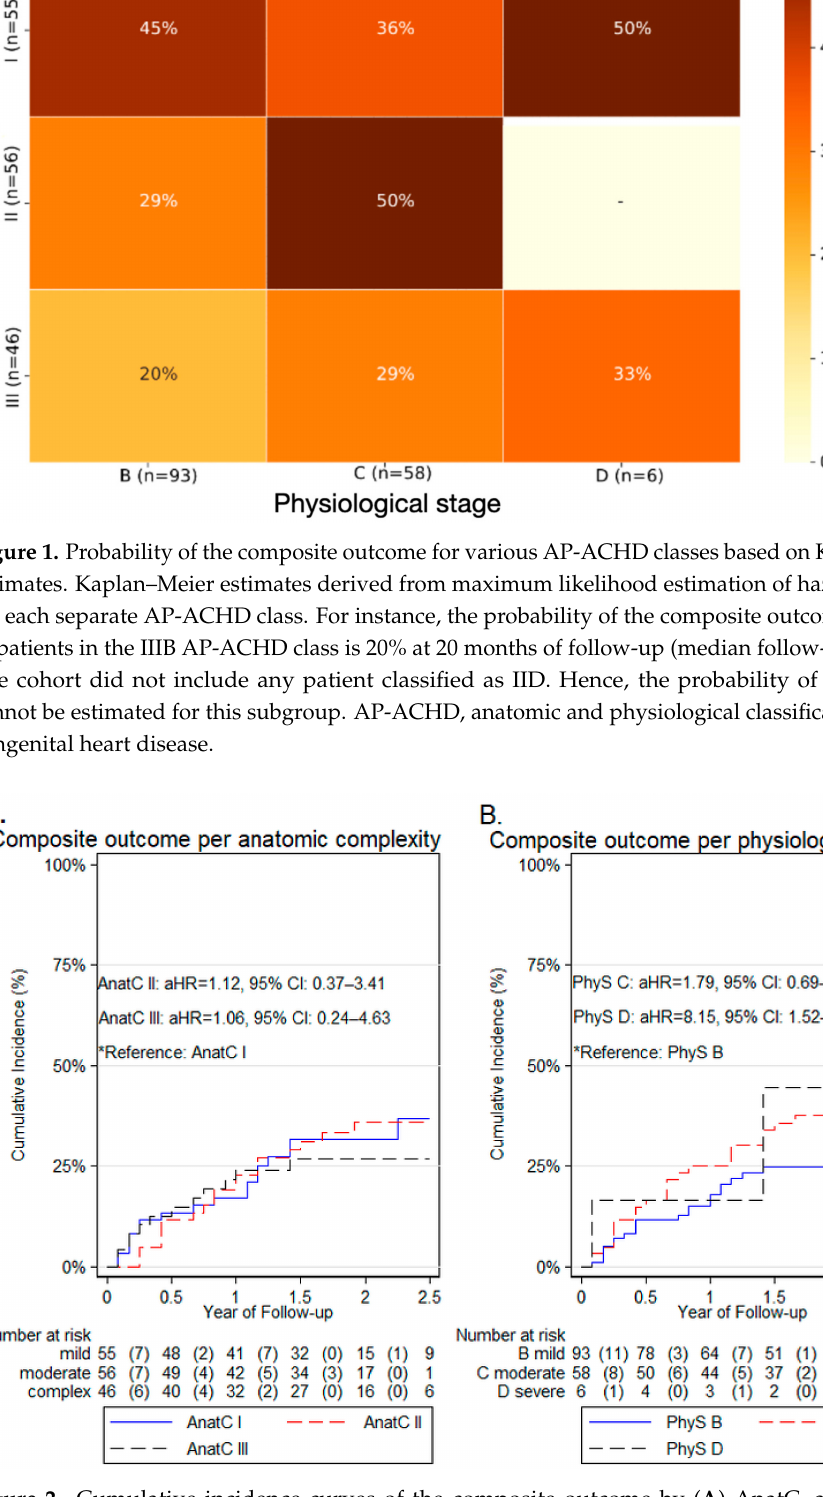
Figure 2. Cumulative incidence curves of the composite outcome by ( A ) AnatC, and ( B ) PhyS. Cumulative incidence curves of the composite outcome by ( A ) AnatC and ( B ) PhyS. AnatC, anatomic class; PhyS, physiological